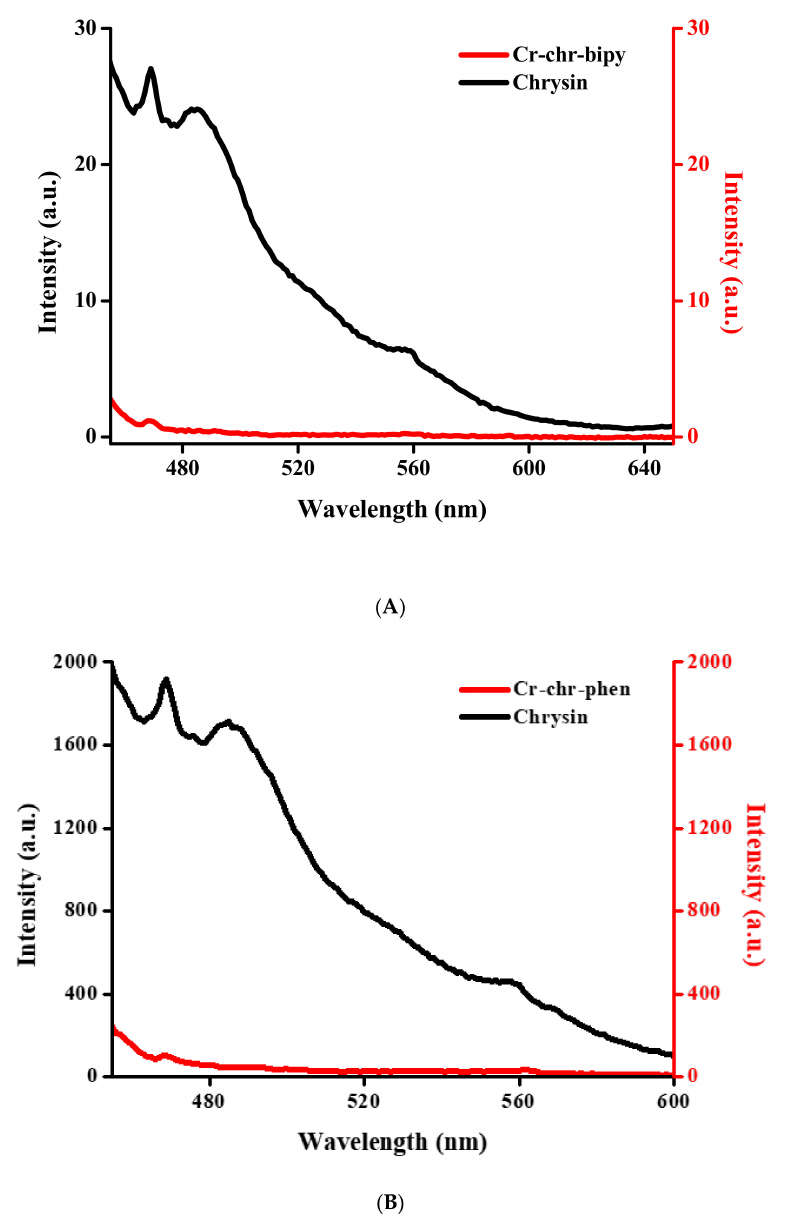
Figure 5. ( A ) Luminescence spectrum of compound 1 compared to that of the free chrysin ligand in solid state. ( B ) Luminescence spectrum of compound 2 compared to that of the free chrysin ligand in the solid